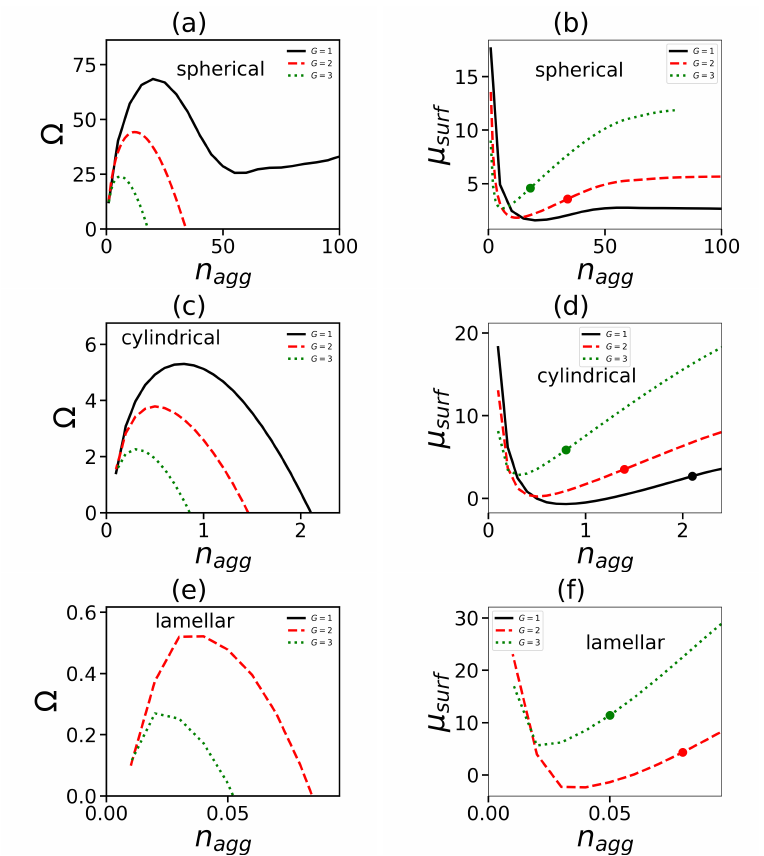
Figure 1. The grand potential Ω ( a , c , e ) and the chemical potential µ surf ( b , d , f ) for spherical ( a , b ), cylindrical ( c , d ), and lamellar ( e , f ) geometries as functions of the aggregation number n agg . Model of surfactant with t = 4 tails and the length of one tail N t =